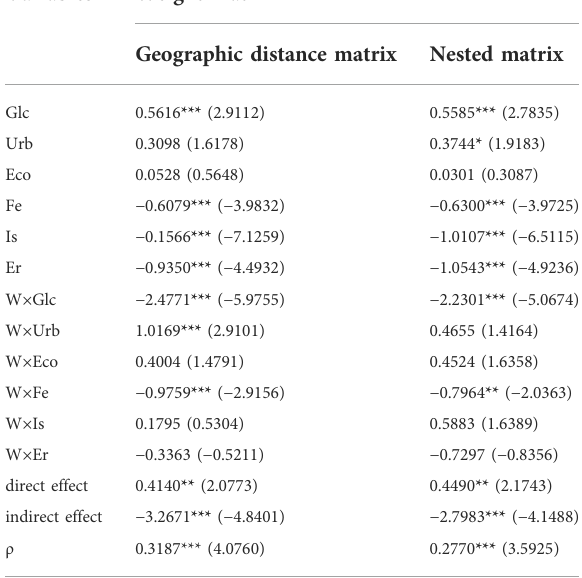
TABLE 5 The results of spatial Durbin